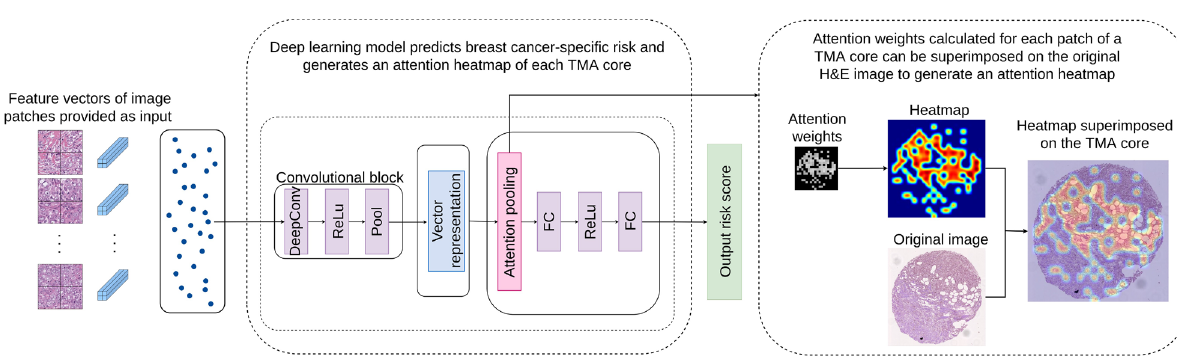
Figure 3. MIL-model can be reconfigured to allow each feature vector to be accepted as input to the network and attention weights be applied on each vector (Model 2). This generates an attention heatmap that highlights tissue areas of interest associated by the network as relevant to a given